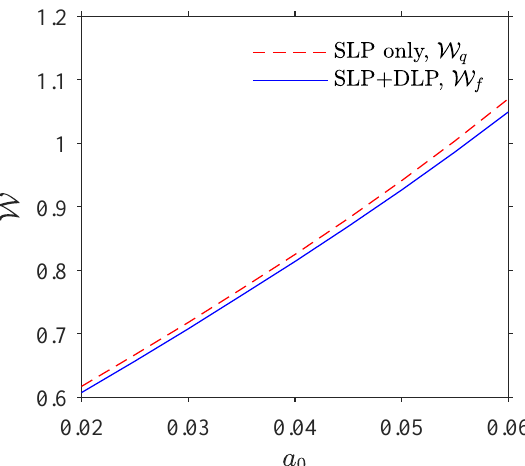
Figure 12. Calculation of time-averaged rate of working for undulatory swimmers of radius a 0 ∈ [ 0.02,0.06 ] in an infinite fluid, comparing the result with what was computed from the single- layer density only W q , and the full boundary integral equation with physical density W f